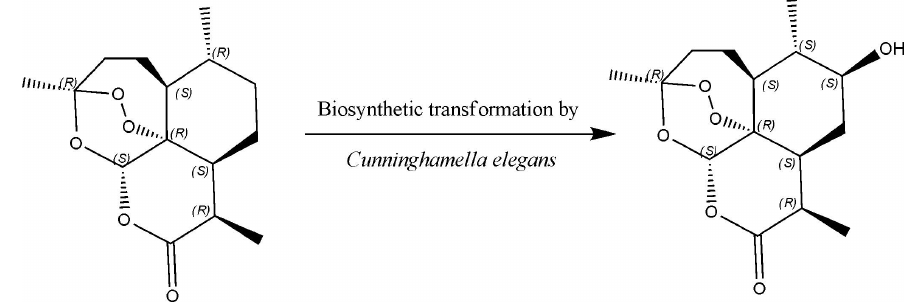
Figure 1 View of the molecular structure of ( I ) with displacement elipsoids drawn at the 50% probability level. Hydrogen atoms are omitted for